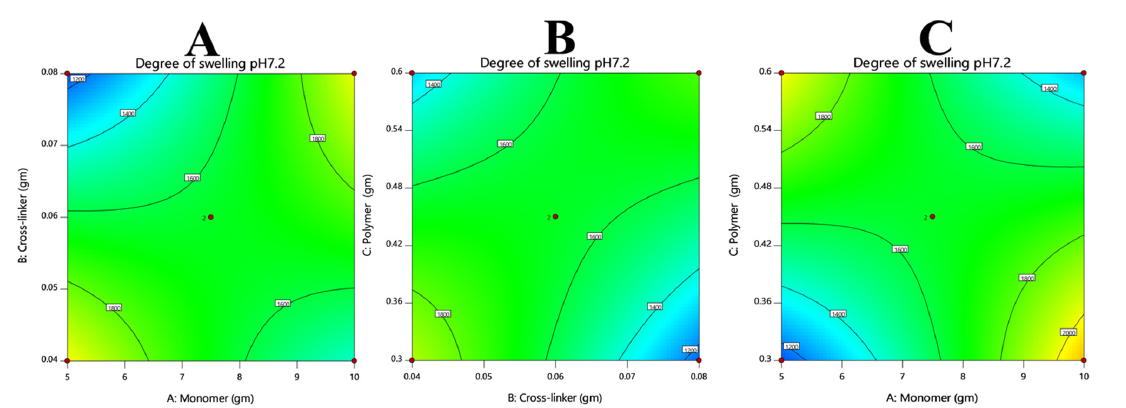
Figure 4. Illustrates the effects of varying concentrations of monomer and crosslinker ( A , D ), pol- ymer and crosslinker ( B , E ), and polymer and monomer ( C , F ) on the degree of swelling. It is clearly evident that both polymer and monomer had a positive effect on the swelling index of a hydrogel, whereas the crosslinker showed the opposite effect.